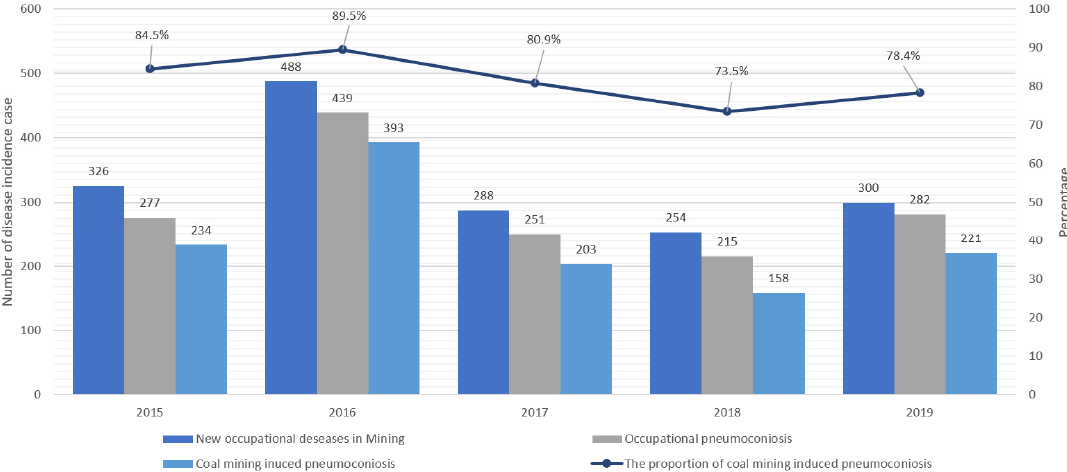
Figure 1. Share of new pneumoconiosis cases in Poland caused by coal mining in the years 2013–2017 [8].